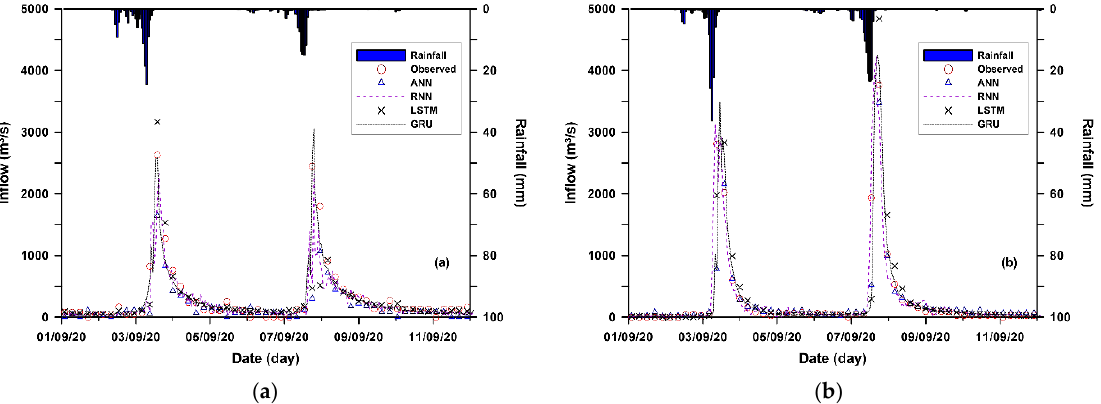
Figure 9. Comparison of observations and predictions for Typhoon Maisak and Haishen. ( a ) Andong Dam. ( b ) Imha Dam. Table 10. Predicted inflow to Andong Dam by typhoon cases.